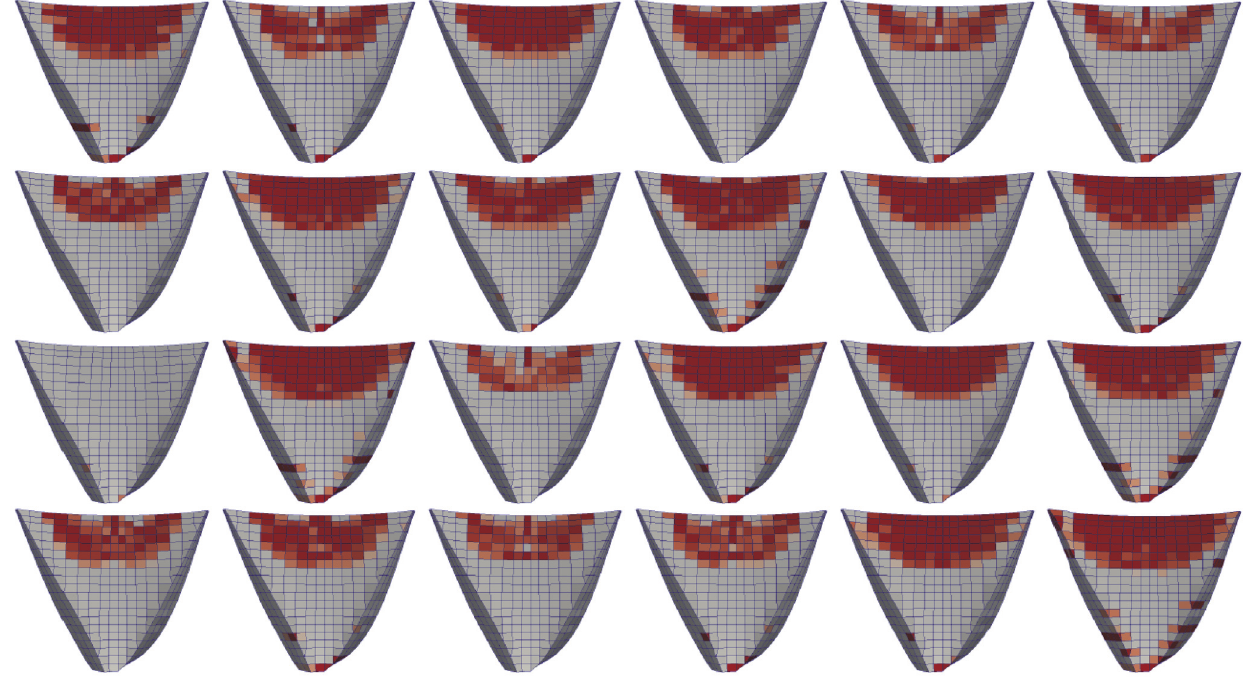
Figure 9: Distribution of first crack on downstream face; top left: Sim-1; first row: 1 to 6; bottom right: